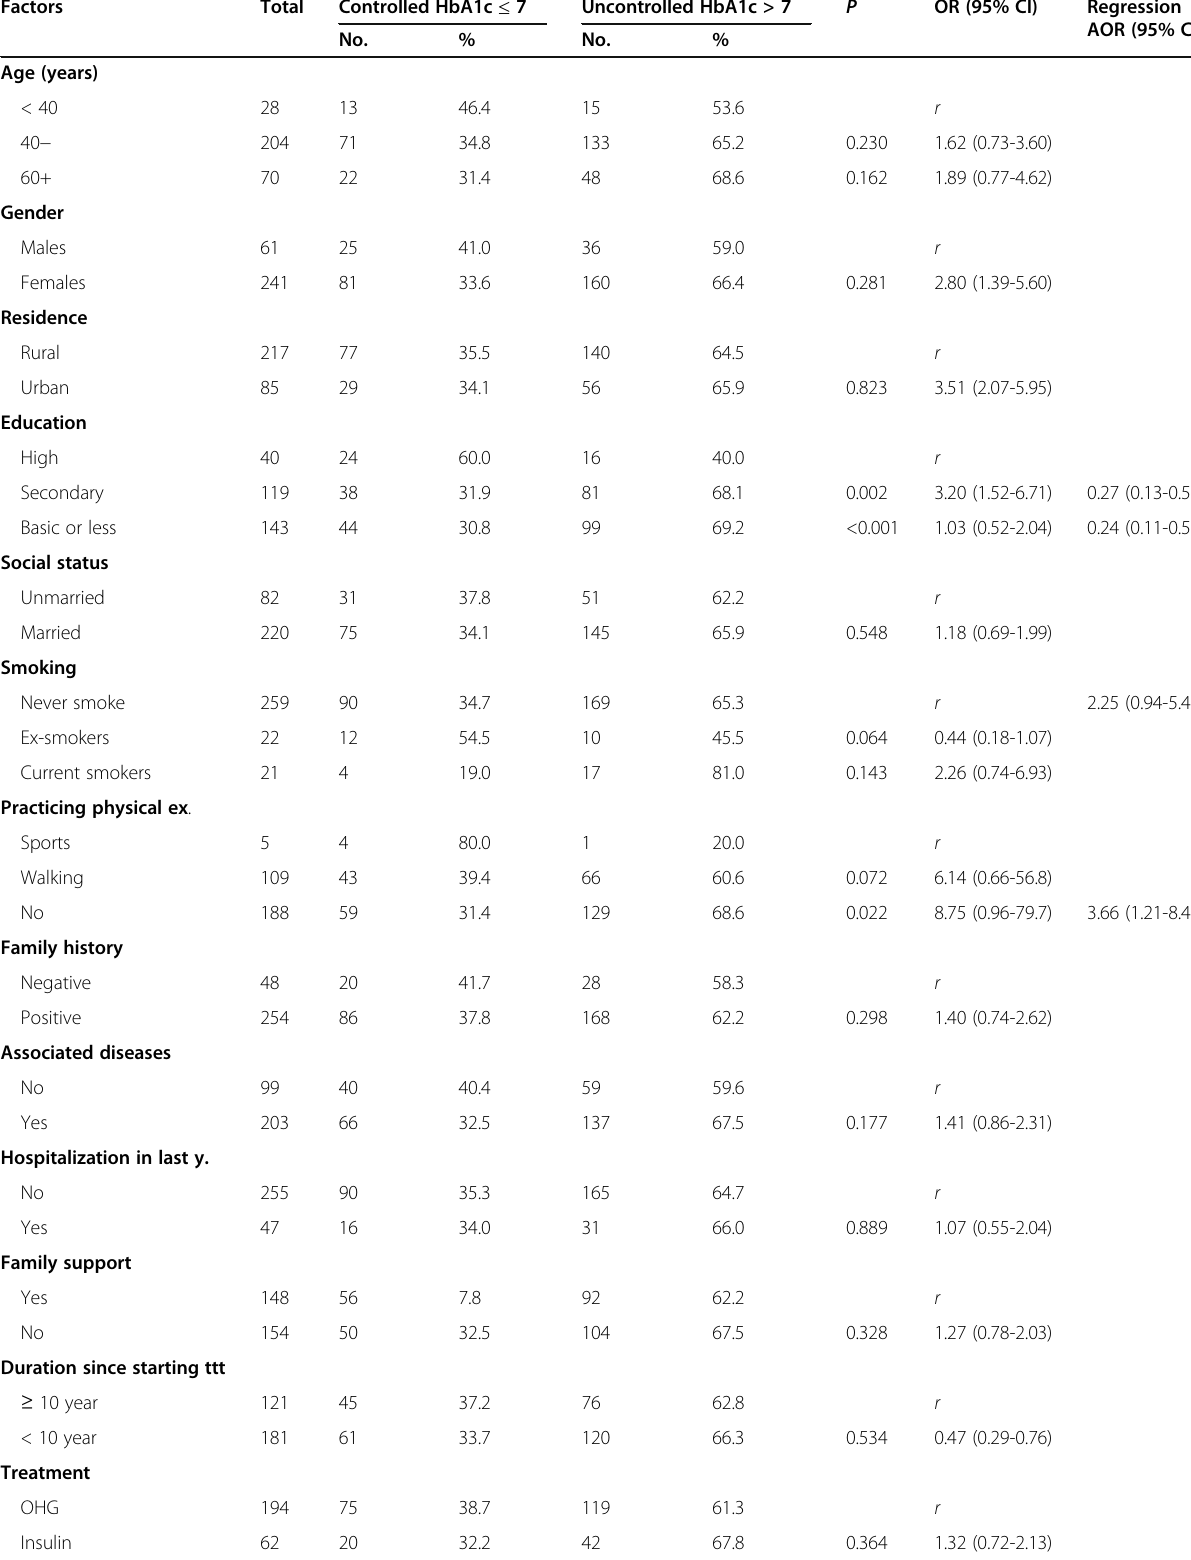
Table 1 Relationship between controlled blood glucose and some factors of the studied subjects